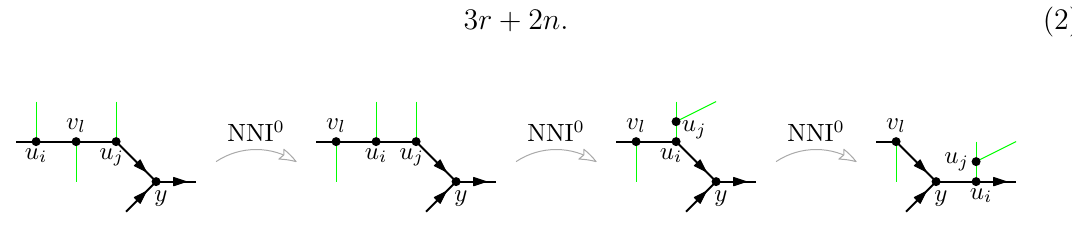
Figure 12: NNI 0 used in Step 2 to obtain a hand-cuffed tree N endpoint follows this endpoint to its regrafting